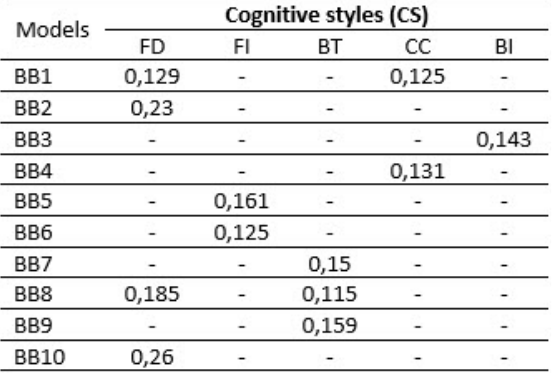
Table 2. Style predictors ratio (BB models).